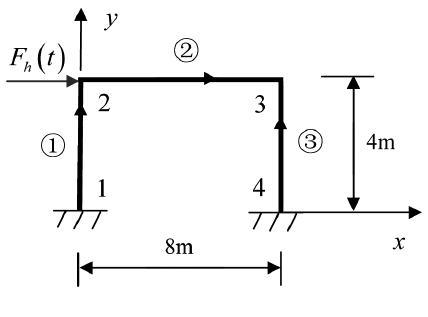
Fig. 2. Plane frame.